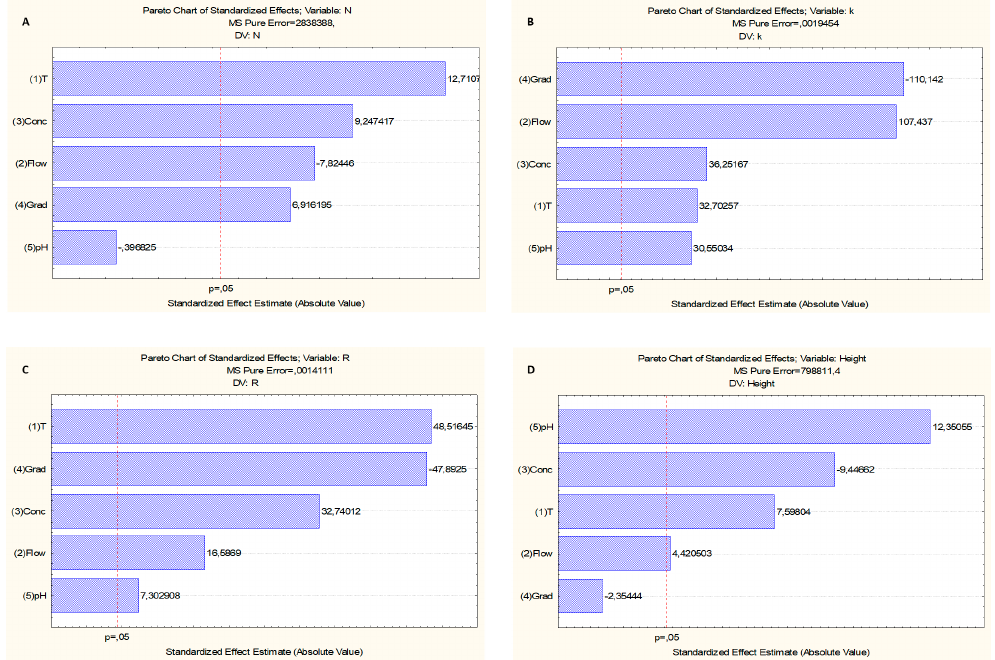
Figure 1. Pareto chart showing the standardized effect of independent variables and their interaction on the ( a ) Efficiency (N); ( b ) Retention factor ( k ); ( c ) Resolution (R); and, ( d ) Peak height (h). The length